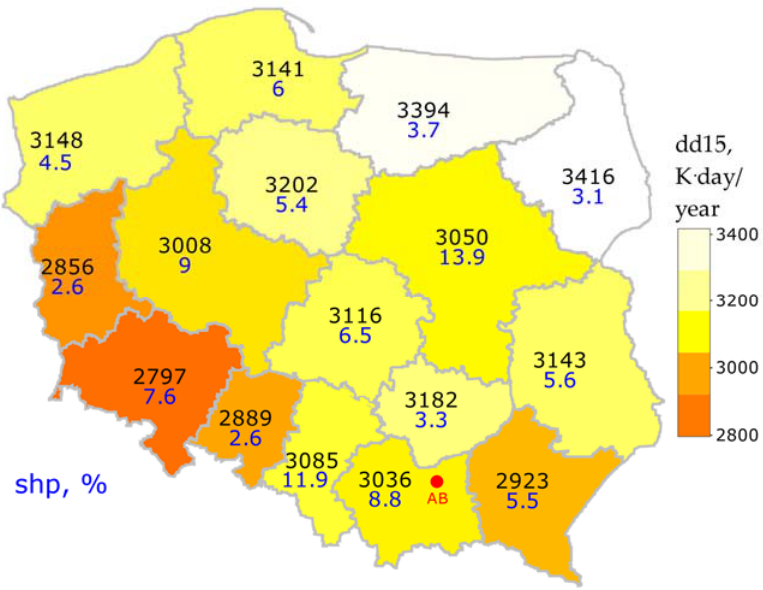
Figure 4. Map of Poland with degree–day values for each voivodship (color scale: dd15, black color) and the percentage share of the number of households in the voivodship in relation to the total for the whole country (shp—blue color). The location of the analyzed building is also marked (AB).